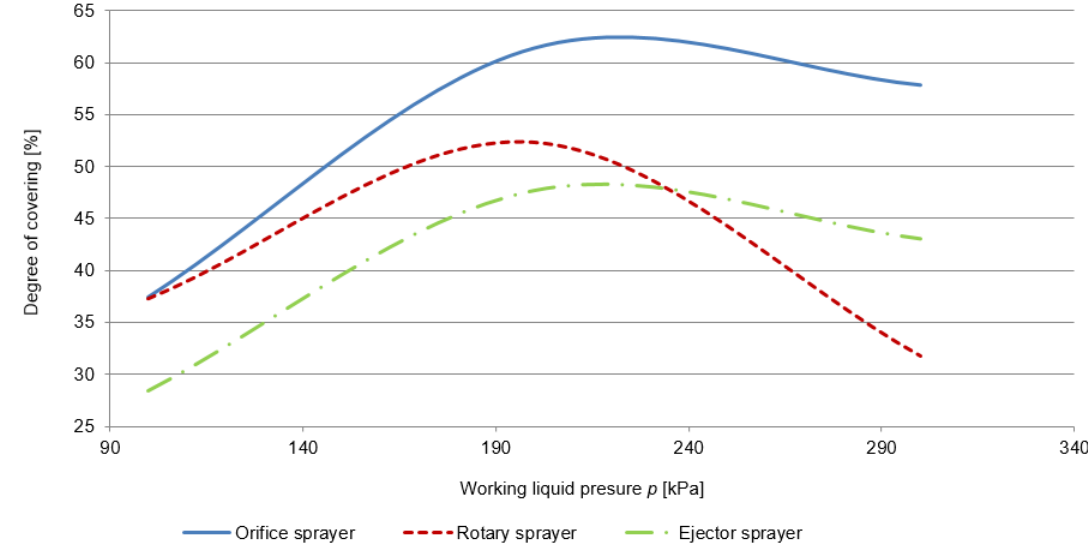
Figure 6. The degree of seed potato covering with the dressing substance for the electronically controlled sprayer valve positioned at a distance S of 100 mm from the seed potato fall axis.